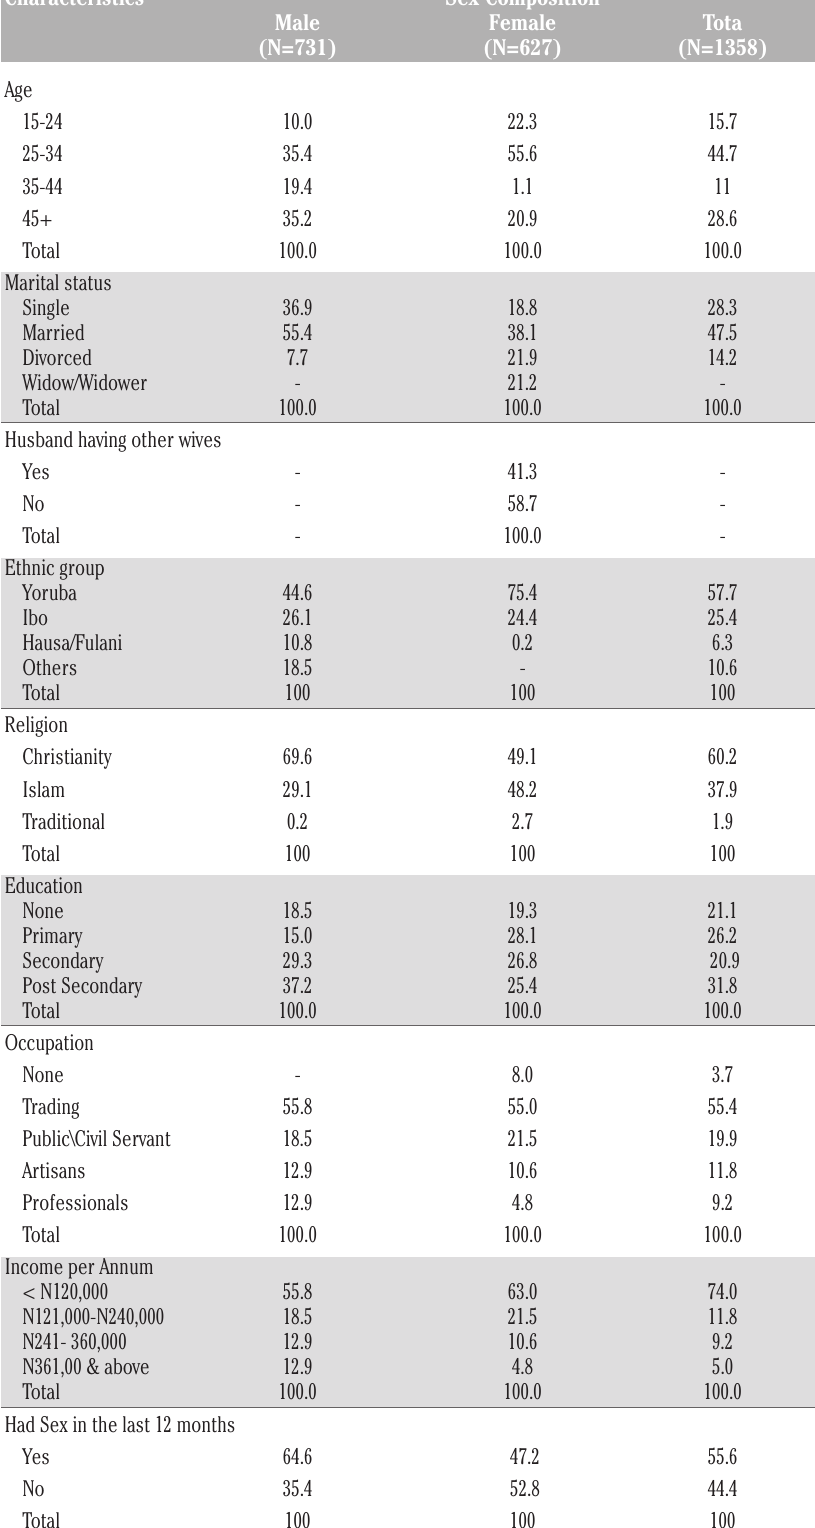
Table 2. Socio-demographic characteristics of respondents.